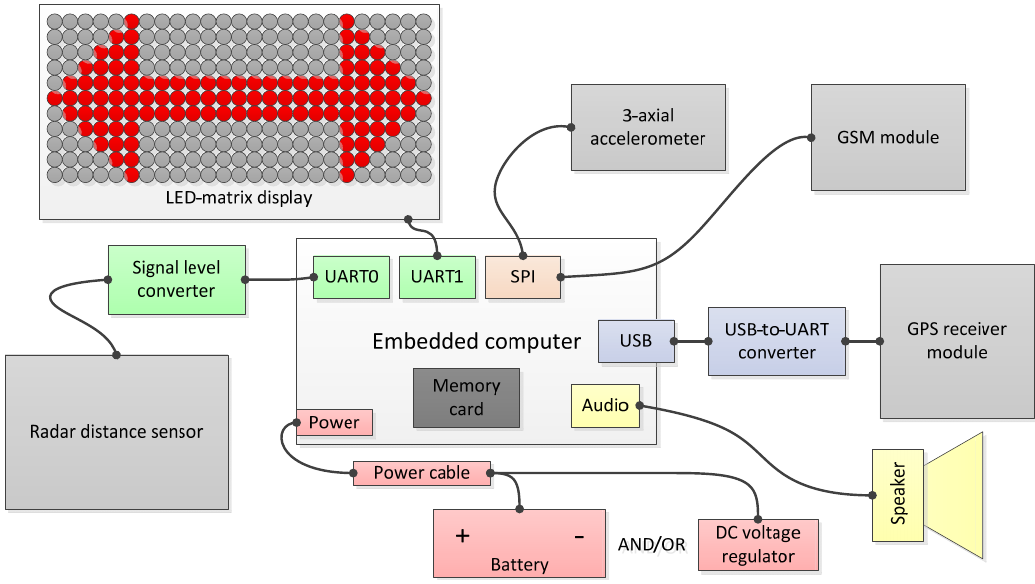
Figure 2. Required components for the selected concept.